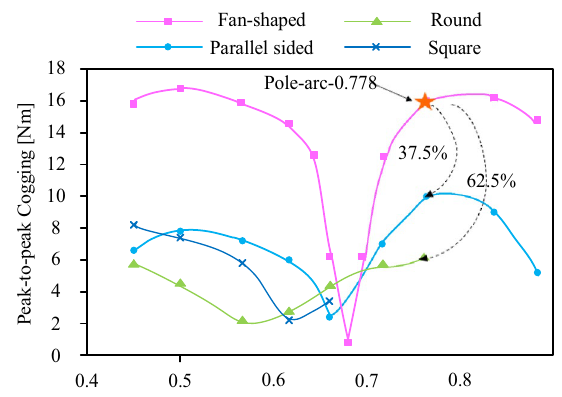
Figure 32 Peak-to-peak cogging torque comparison